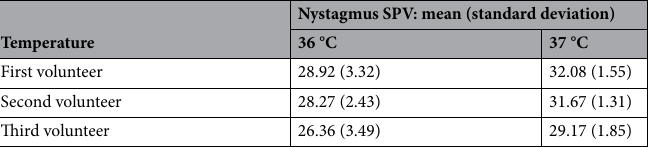
Fig. 4B–D. The differences between the maximal transcupular pressure, cupula deformation, and cupula shear